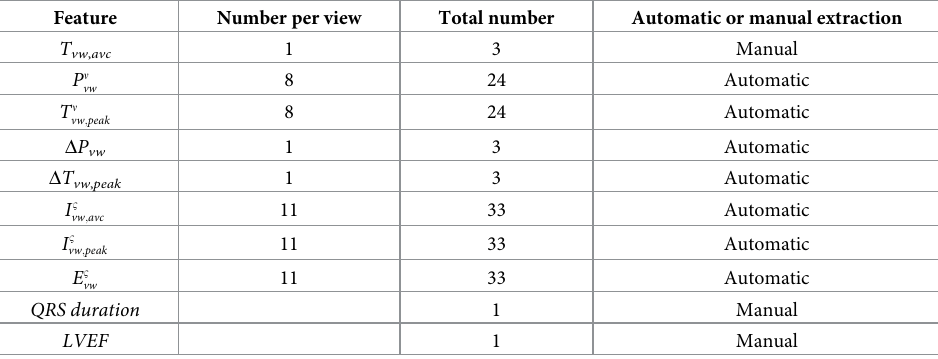
LVEF Manual The last column shows if the subset is automatically or manually obtained. Symbols ν 2 { sg , Mean , Std } and B 2 { sg , Mean , Std , sd 1, sd 2, sd 1 − sd 2}.